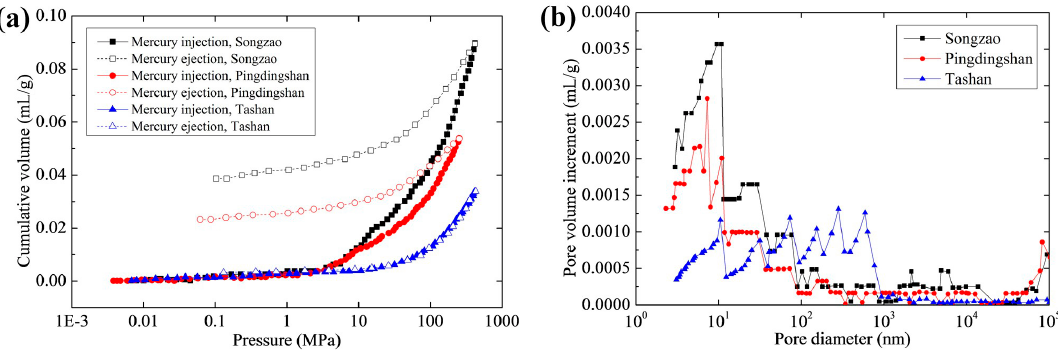
Figure 13. ( a ) Mercury intrusion experiment curves; ( b ) Distribution curves of pore volume of coal samples.